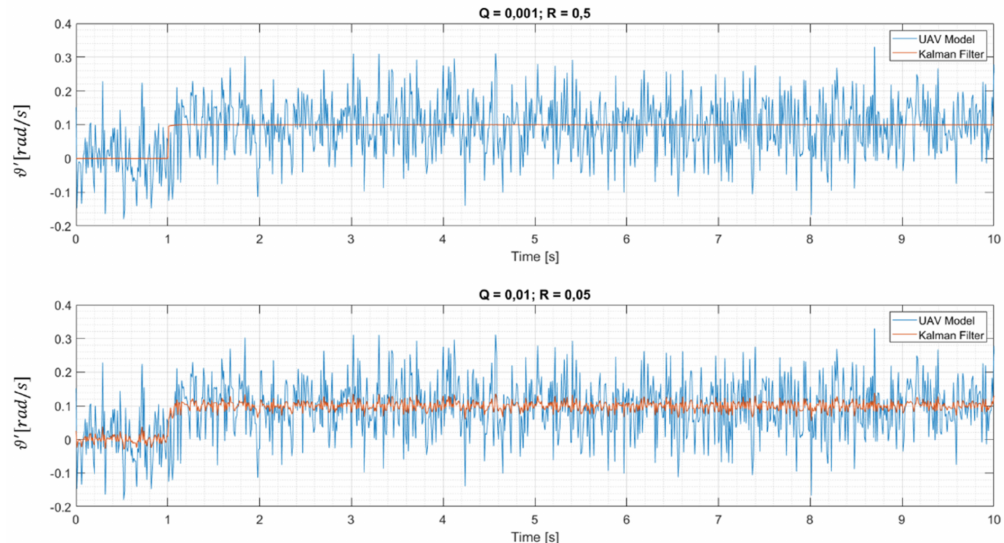
Figure 18. Graphical course of angular velocity for UAV speed 90